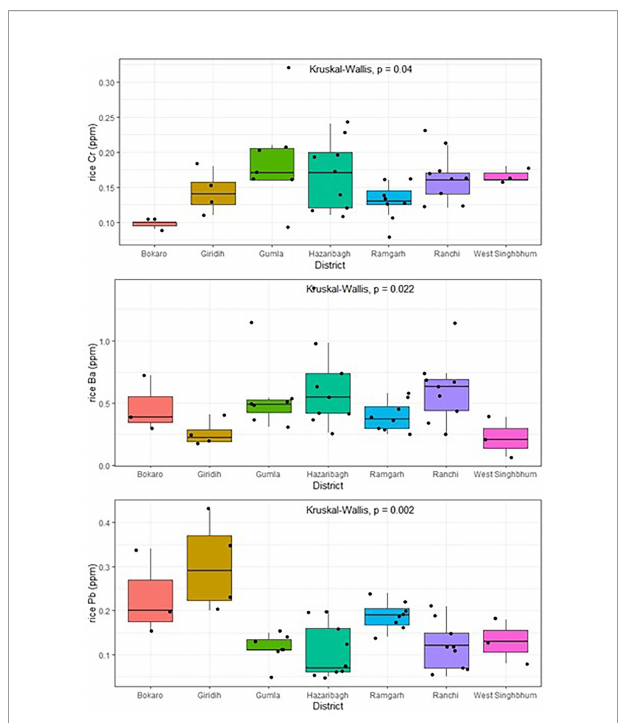
FIGURE 9 | Rice mineral distribution across the seven districts in